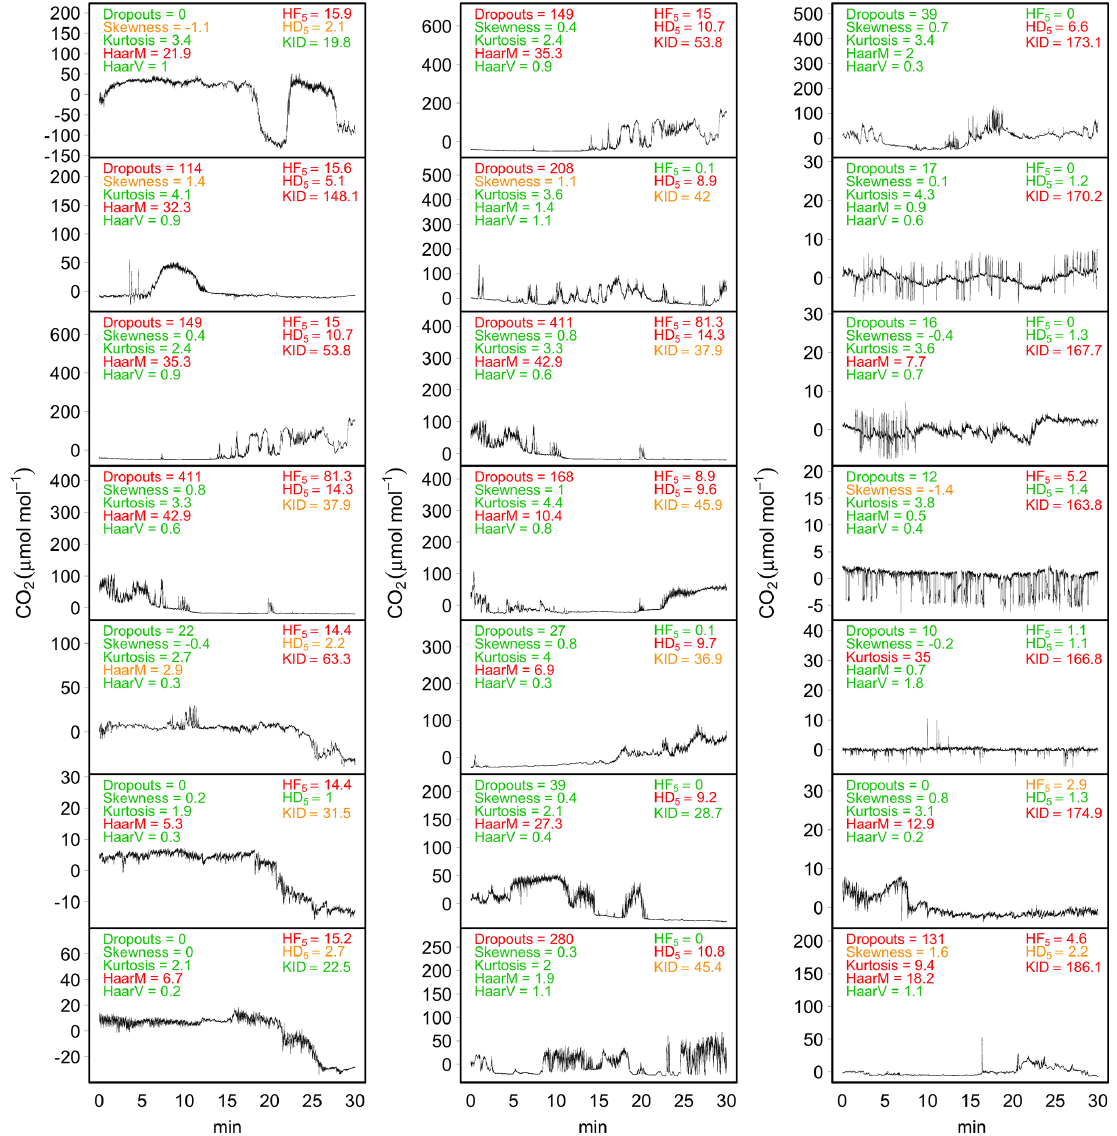
Figure 7. Application of tests for structural change detection on a selection of CO 2 time series (µmolmol − 1 , after mean removal) collected at the BE-Lon site. The statistics of dropouts, skewness, kurtosis, discontinuities in mean (HaarM) and variance (HaarV) tests as described by VM97 and the statistics of HF 5 , HD 5 and KID tests described in Sect. 2.2.1 are reported at the top of each panel. For each test, green text indicates NoEr (no flag by VM97 tests), orange text indicates ModEr (soft flag) and red text indicates SevEr (hard